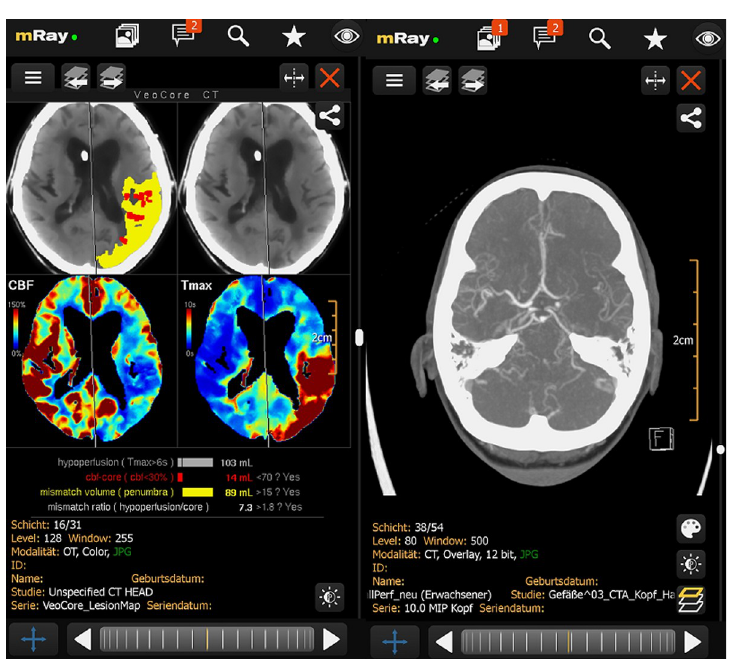
Fig 1. Veocore lesion map with core and mismatch and LVO on a CTA scan viewed with mRay.